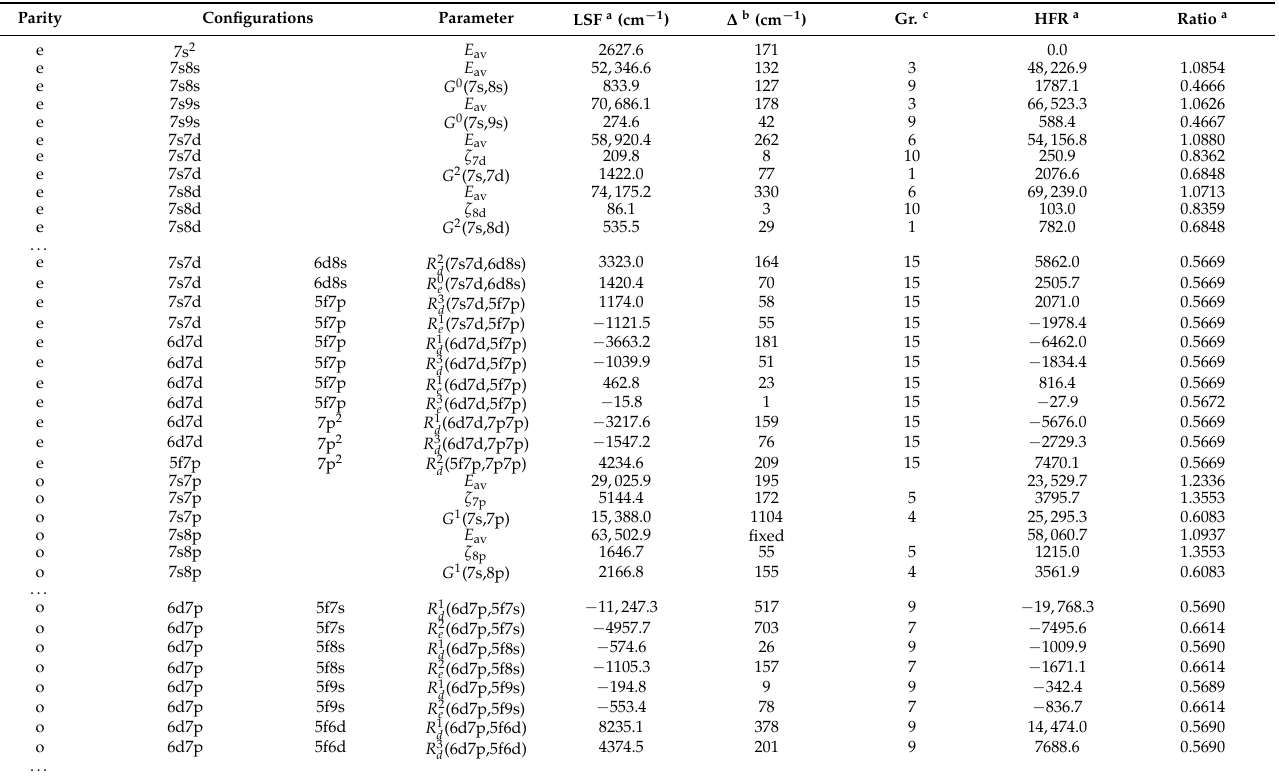
Table 6. Parameters of the least-squares fit for Ac